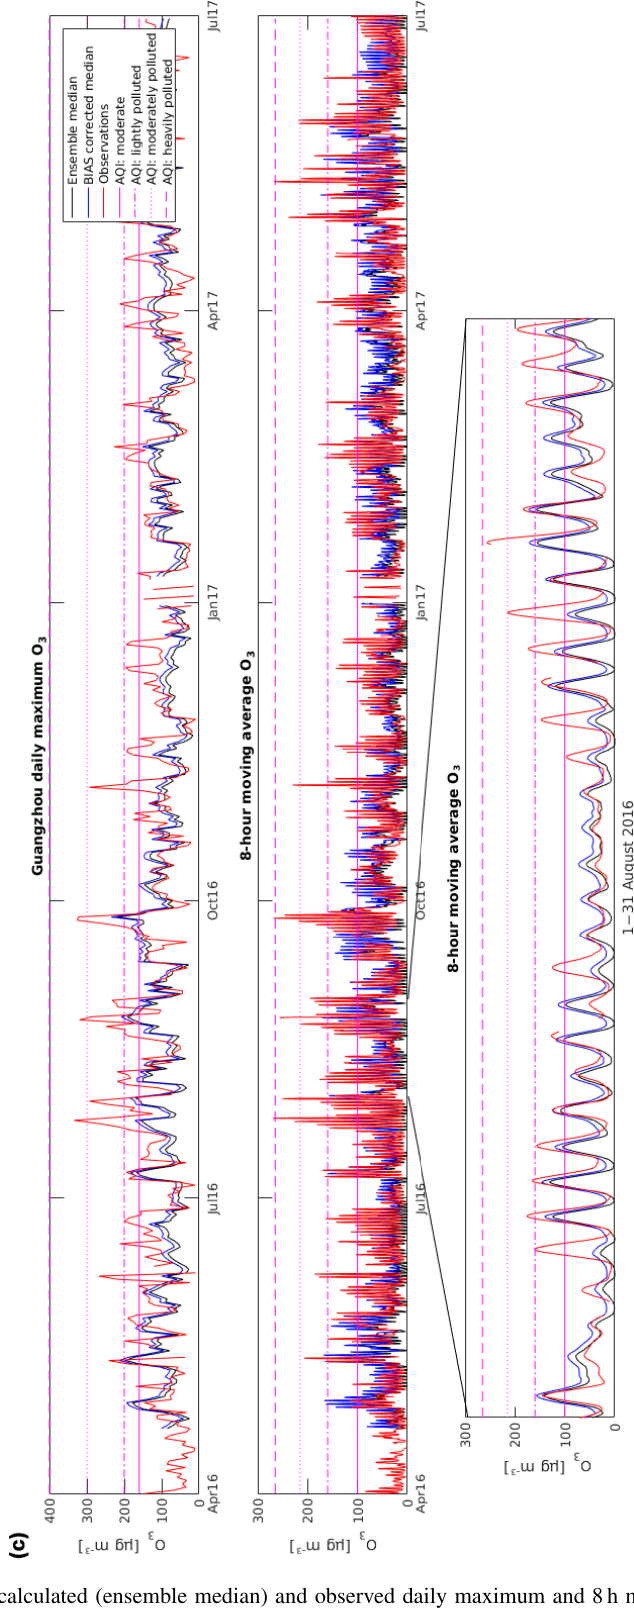
Figure 15. (a, b) Time series of calculated (ensemble median) and observed daily maximum and 8h moving average O 3 for Beijing and Shanghai together with the bias-corrected calculated time series. (c) Time series of calculated (ensemble median) and observed daily maxi- mum and 8h moving average O 3 for Guangzhou together with the bias-corrected calculated time